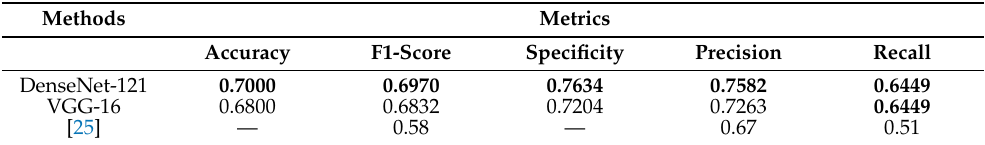
Table 3. Results obtained by the compared models considering the test sets for the classification scenario of the entire database. The best values are presented in